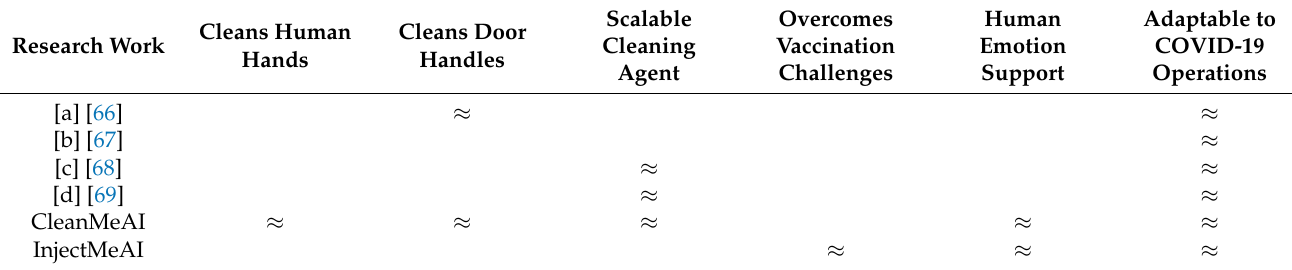
Table 3. Comparison of projects CleanMeAI and InjectMeAI with similar